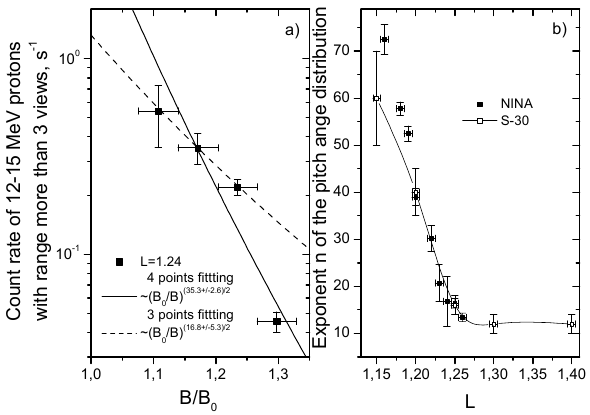
Fig.3. Fig. 3. (a) Counting rates of 12–15MeV protons with a range more than 3 views at the geomagnetic shell L=1.24 as a function of geo- magnetic latitude B/B 0 . (b) The exponent n of the equatorial pitch angle distribution as a function of the L-shell value from the data of the NINA and S-30 experiments (Fischer et al.,